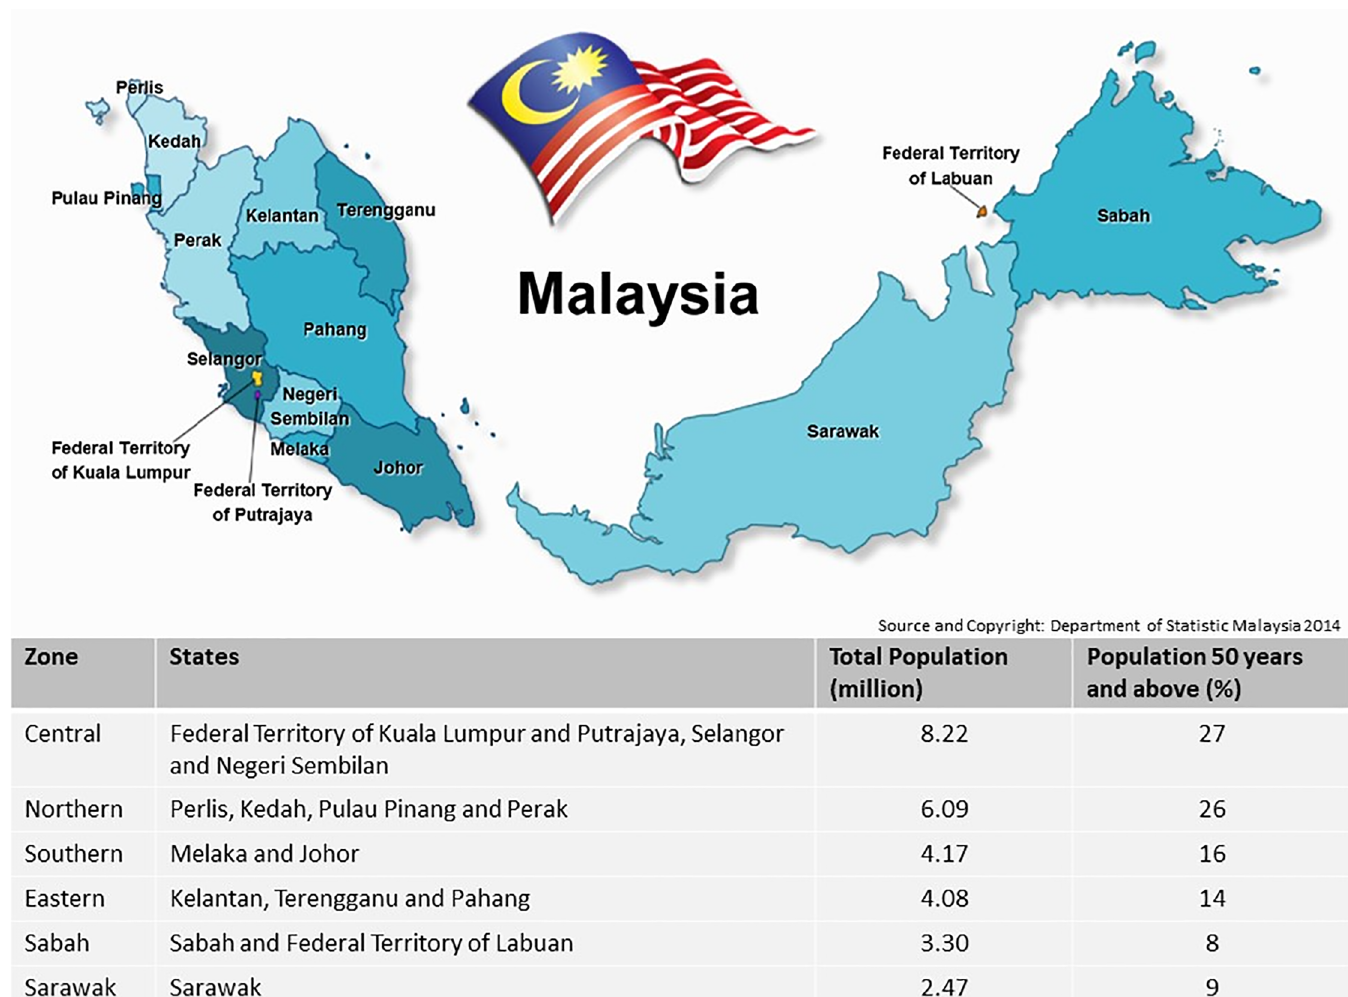
Fig 1. Population and states in Malaysia. Source: Department of Statistics,